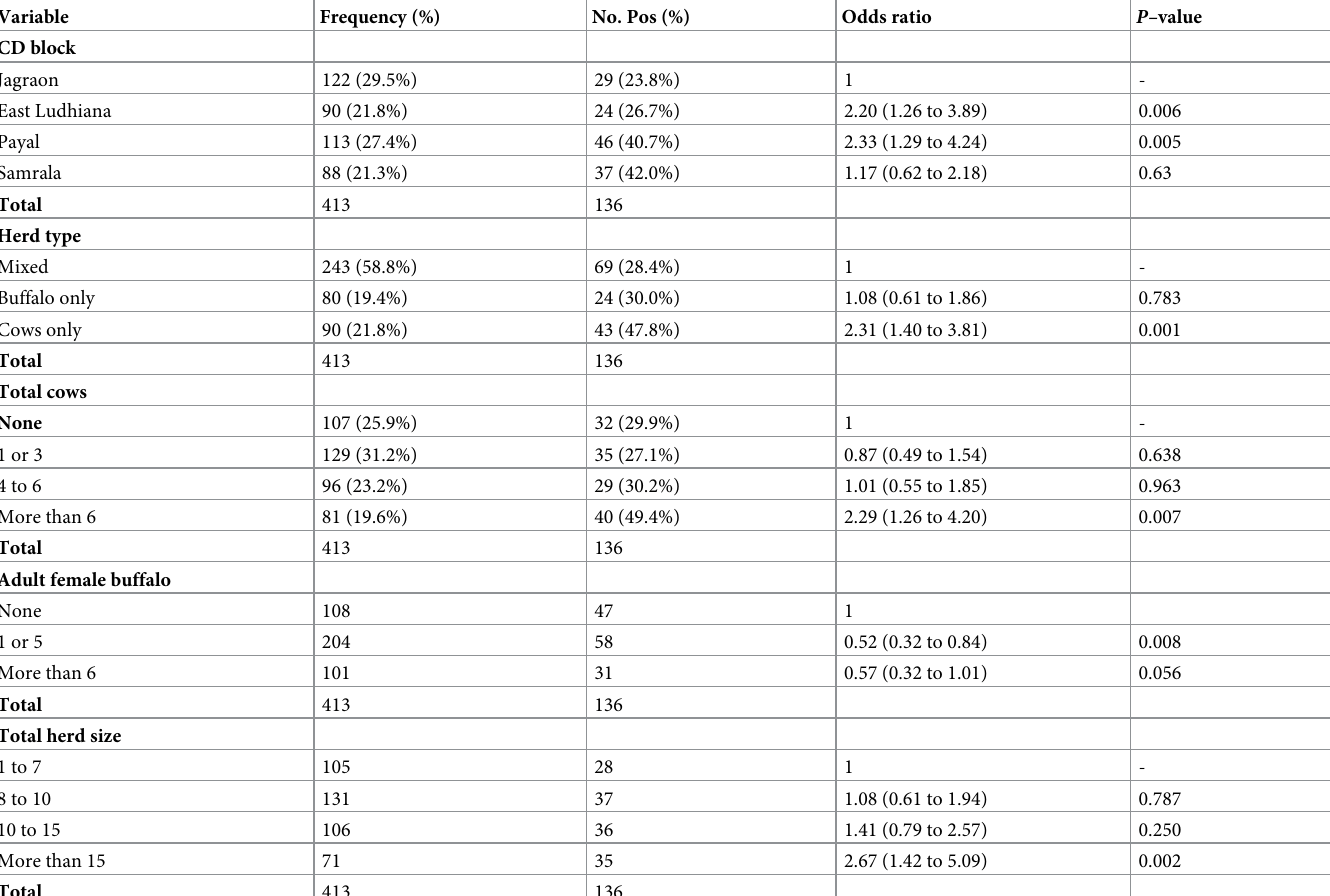
Table 2. Farm-level univariate analysis for associations between farm demographics and at least one animal in the herd testing seropositive using logistic regression with village included as a random